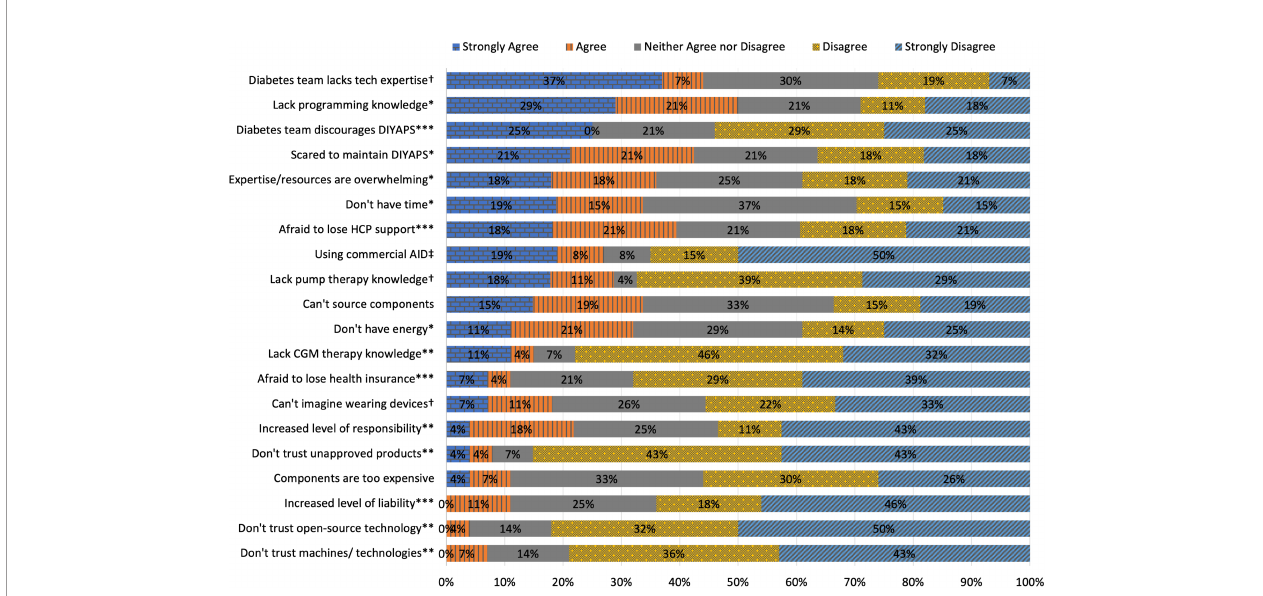
FIGURE 1 | N=56; responses to statements regarding interest in building an open-source AID ( “ I would be interested in building a DIYAPS, but …” ). Participants rated statements on a 5-point Likert scale (strongly agree, agree, neither agree nor disagree, disagree, strongly disagree). The responses were classi fi ed into three dimensions using principal component analysis and are labeled accordingly (*Building and Maintenance, **Knowledge and Trust in Technology, ***Support and Liability, † were excluded due to reduced reliability, ‡ was excluded after principal component analysis due to insuf fi cient loading).